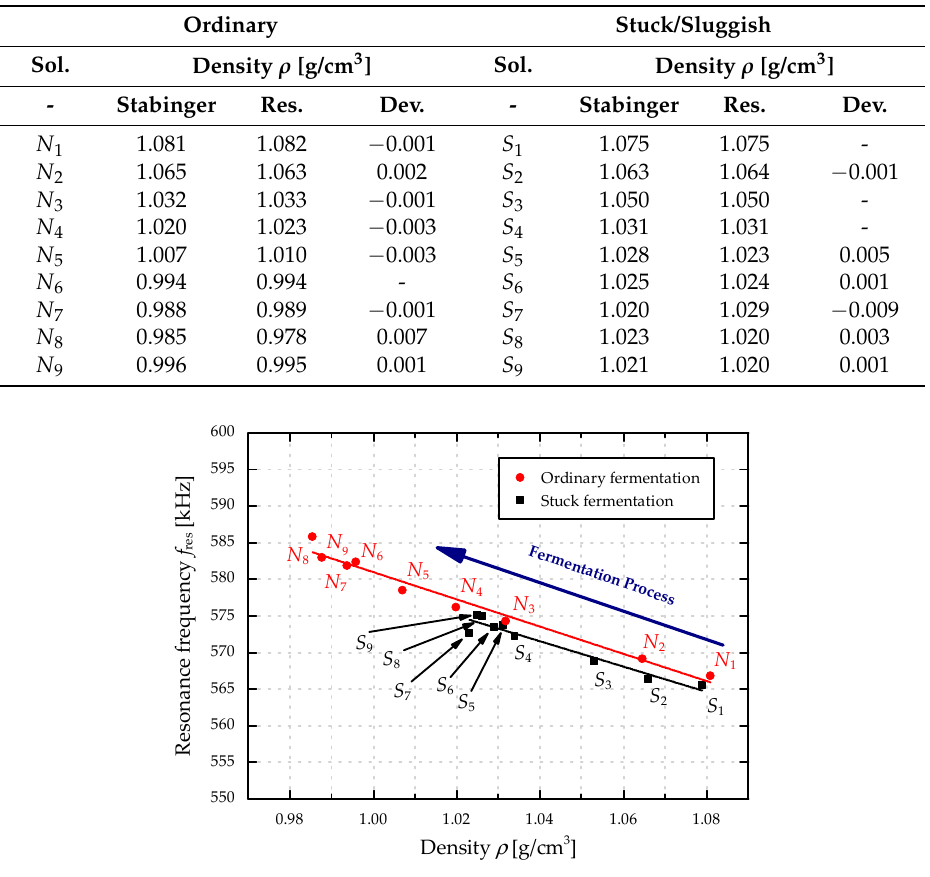
Figure 10. Correlation between the measured resonance frequencies and the corresponding density values for an ordinary ( red ) and a stuck ( black ) fermentation process.